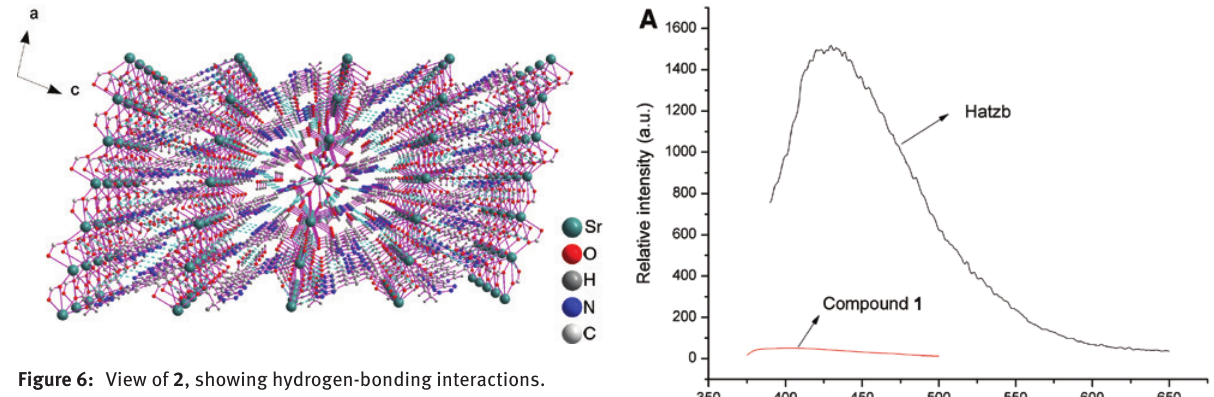
Figure 6: View of 2 , showing hydrogen-bonding